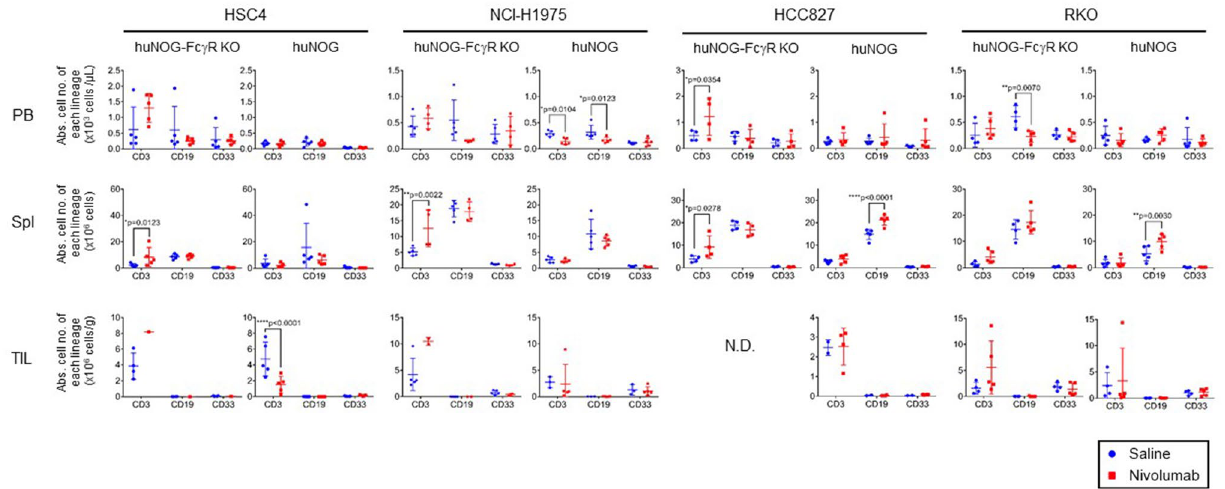
Figure 6. Enumeration of human leukocytes in tumor-bearing humanized mice treated with nivolumab. Mononuclear cells were prepared from the indicated tissues of huNOG or huNOG-FcγR −/− mice. The cells were analyzed by flow cytometry. The absolute cell number of each cell lineage was calculated by multiplying the total cell number with the frequency. Data from a representative experiment were shown for each tumor cell line. The numbers of mice are as follows. For HSC4 and RKO, huNOG mice (n = 5 or 5 for saline- or nivolumab-treated mice, respectively) and huNOG-FcγR −/− mice (n = 4 or 5 for saline- or nivolumab-treated mice, respectively). For NCI-H1975, huNOG mice (n = 5 or 5 for saline- or nivolumab-treated mice, respectively) and huNOG- FcγR −/− mice (n = 5 or 4 for saline- or nivolumab-treated mice, respectively). For HCC827, huNOG mice (n = 5 or 5 for saline- or nivolumab-treated mice, respectively) and huNOG-FcγR −/− mice (n = 4 or 4 for saline-